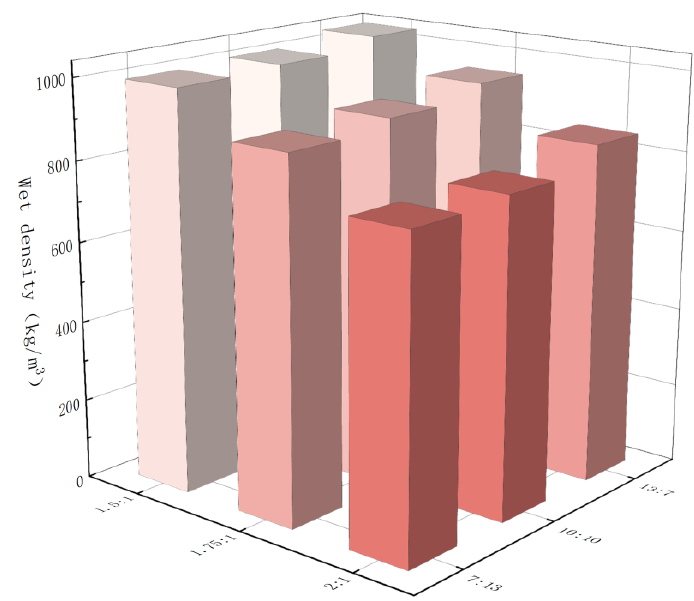
Figure 6. The wet density of the lightweight CLSM.